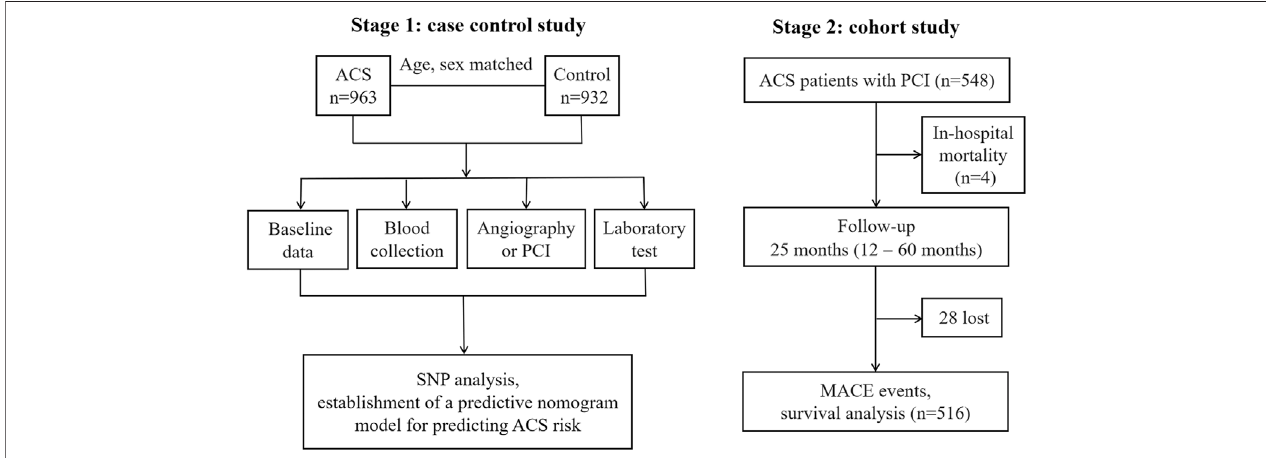
FIGURE 1 | The fl ow chart of study design. PCI, percutaneous coronary intervention; SNP, single nucleotide polymorphism; ACS, acute coronary syndromes; MACE, major adverse cardiovascular